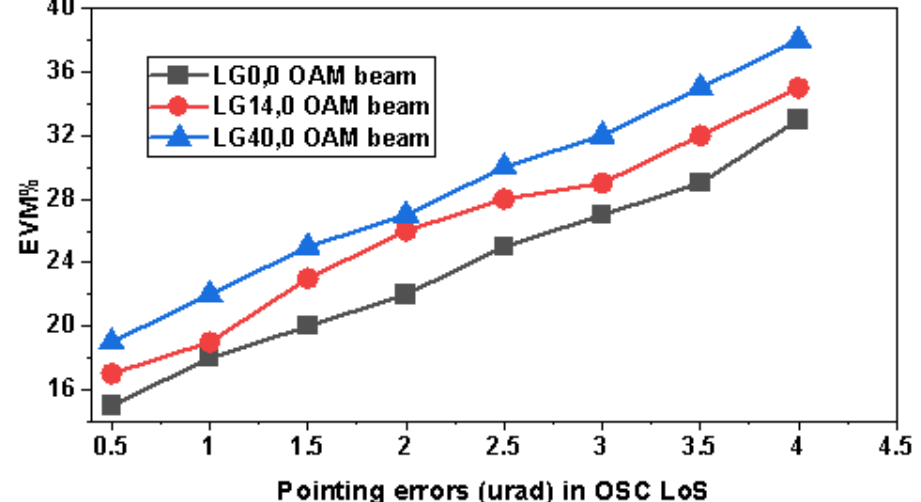
Figure 10. Performance of OAM beams in OSC link having different pointing errors at 10,000 km.